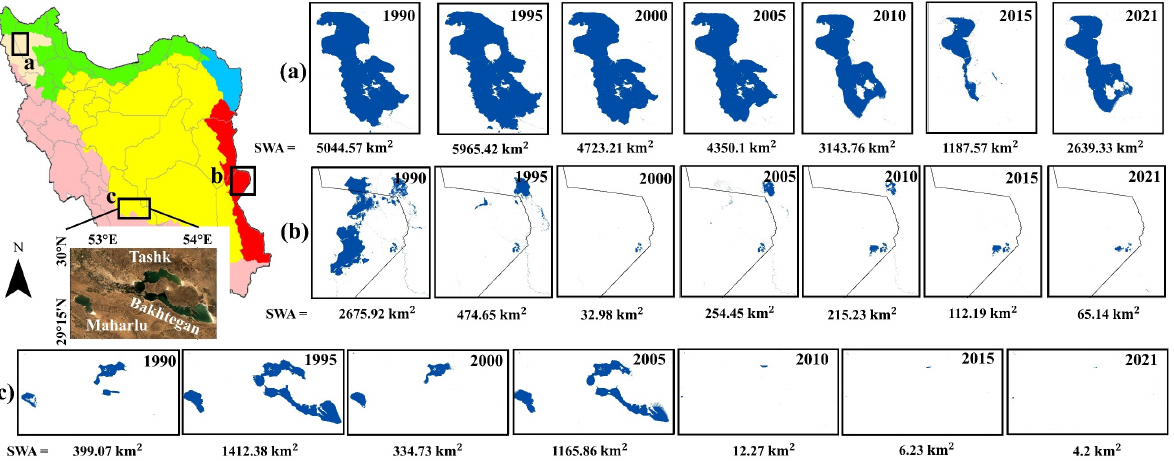
Figure 8. The 5-year changes of ( a ) Lake Urmia, ( b ) Hamoon lake, and ( c ) Bakhtegan, Tashk and Maharlu lakes. An RGB Landsat composite for 1995 demonstrates the location of the Bakhtegan, Tashk, and Maharlu lakes.